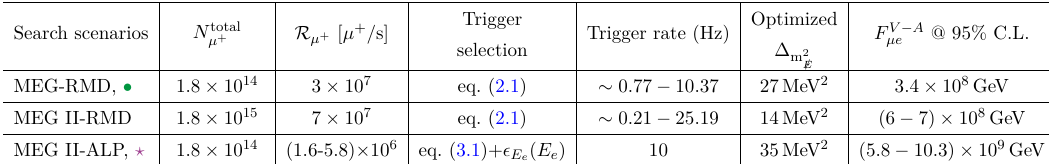
Table 1 . Summary of the searches for µ + → e + aγ at MEG and MEG II. The markers ( • , ? ) correspond to the lines in figure 1. The expected limits are given for an effective massless axion (i.e. with mass below the experimental resolution). MEG II-RMD limits vary depending on the normalization of the RC background, which can be reduced by 50% w.r.t. the measured value at MEG [14]. The trigger rate is estimated in more detail at the end of section 2.1, with a factor of 1 /c RC ≈ 14 uncertainty. The latter affects the reach of the dedicated MEG II-ALP data taking run, where we fix the trigger rate to be 10 Hz and derive two optimal benchmark choices for the beam intensity. These different beam intensities each result in a slightly different projected bound, shown by the width of the purple bands in figure